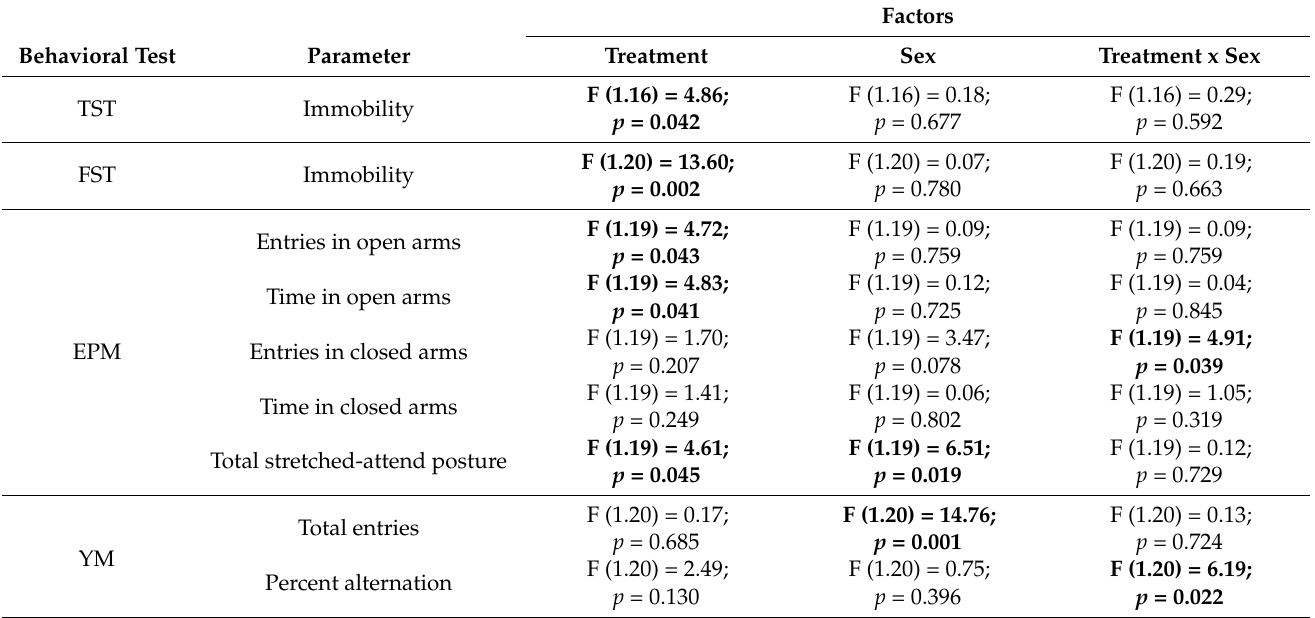
Table 2. Summary of the statistical analysis by two-way ANOVA for the factors: treatment, sex, and treatment x sex.